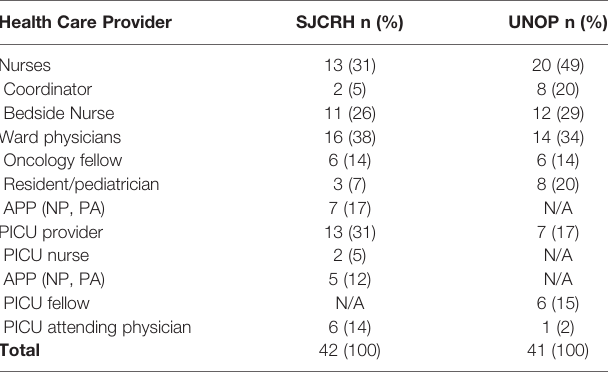
TABLE 1 | Demographics of Interviewed Participants.